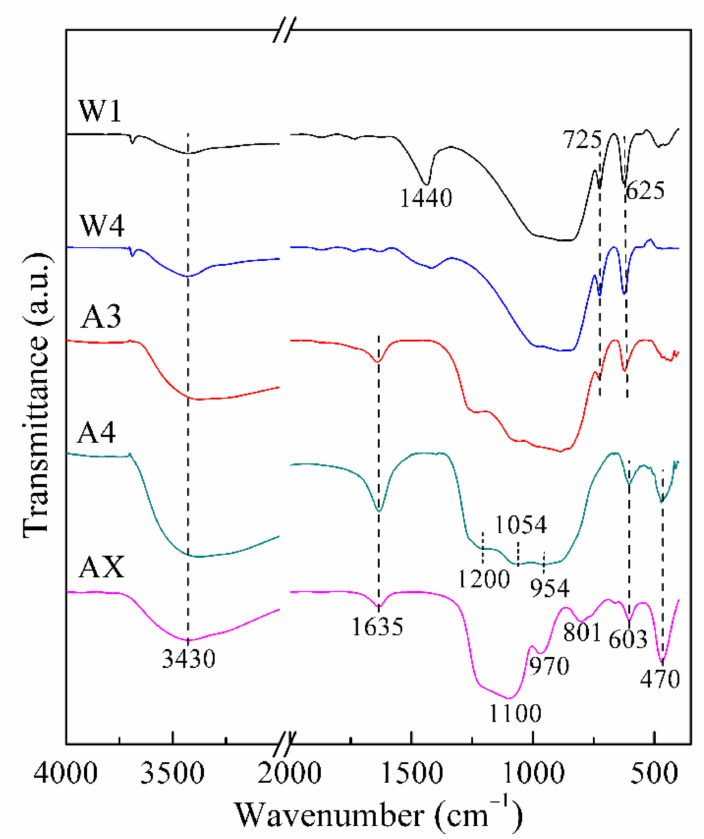
Figure 8. FT-IR spectra of the solid samples from washing natisite with water and sulfuric acid